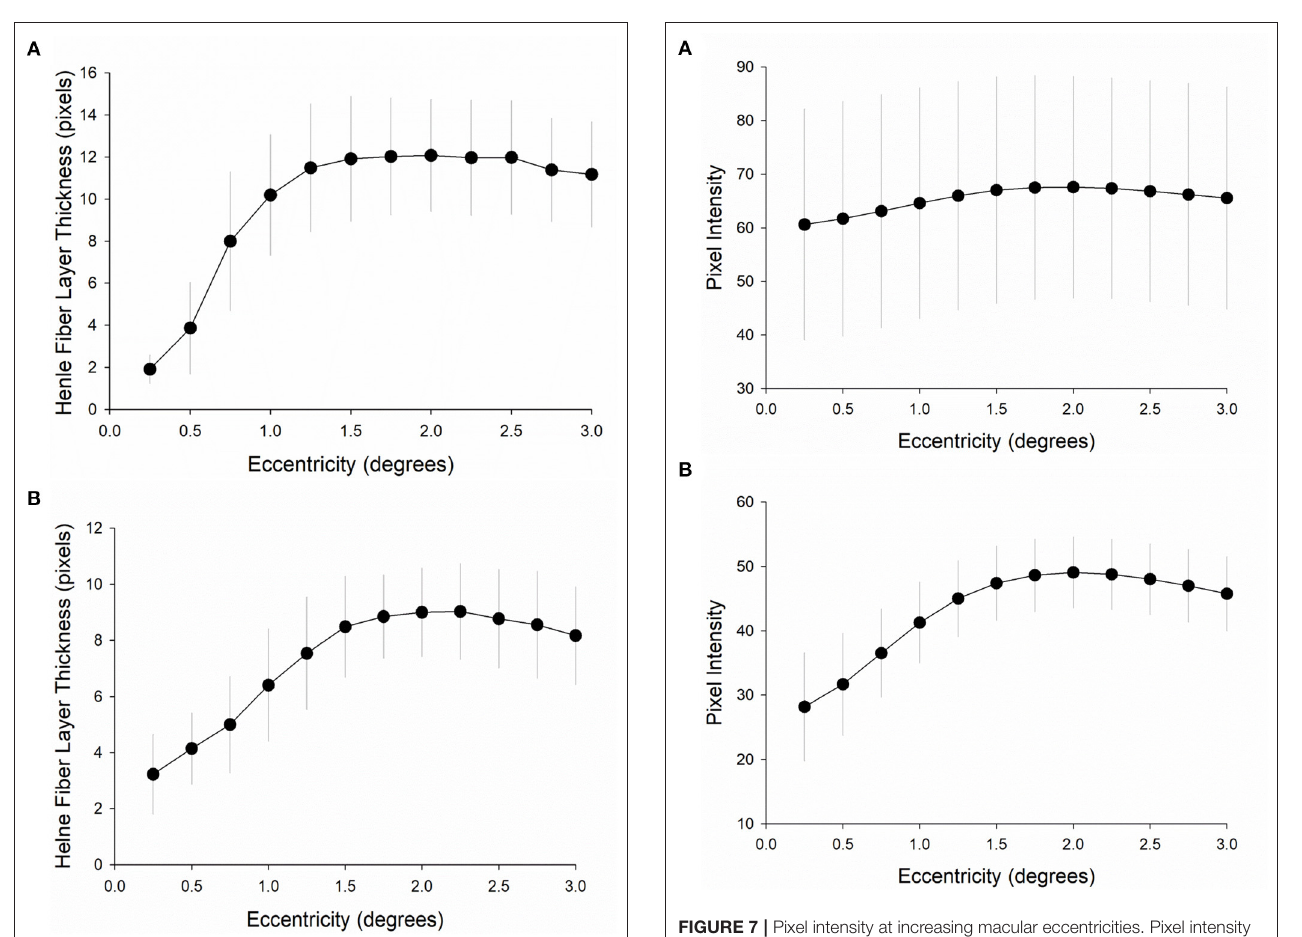
FIGURE 7 | Pixel intensity at increasing macular eccentricities. Pixel intensity was measured at 12 different macular eccentricities (from 0 ◦ to 3 ◦ from the foveal center in 0.25 ◦ steps) (A) in the first cohort (fixed-compensation scanning laser polarimetry, n = 11) and (B) in the second cohort (variable-compensated scanning laser polarimetry, n = 25). Error bars are one standard deviation from the mean